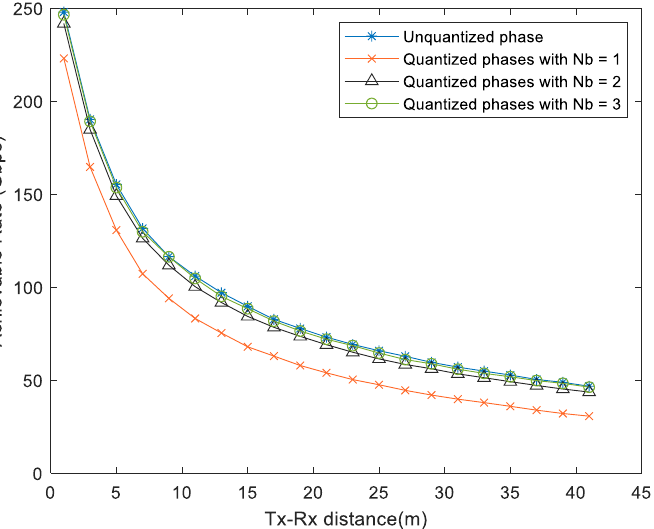
Figure 5. Achievable rate of the proposed APG for the case of discrete phase shifts versus distance between BS–User, considering N RIS = 81.